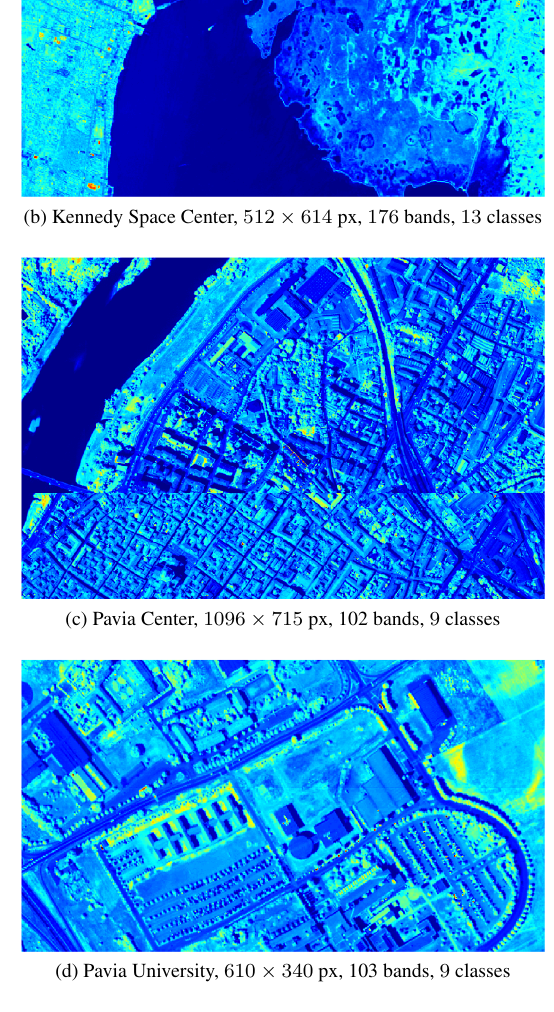
Figure 2: Sample bands of Pavia